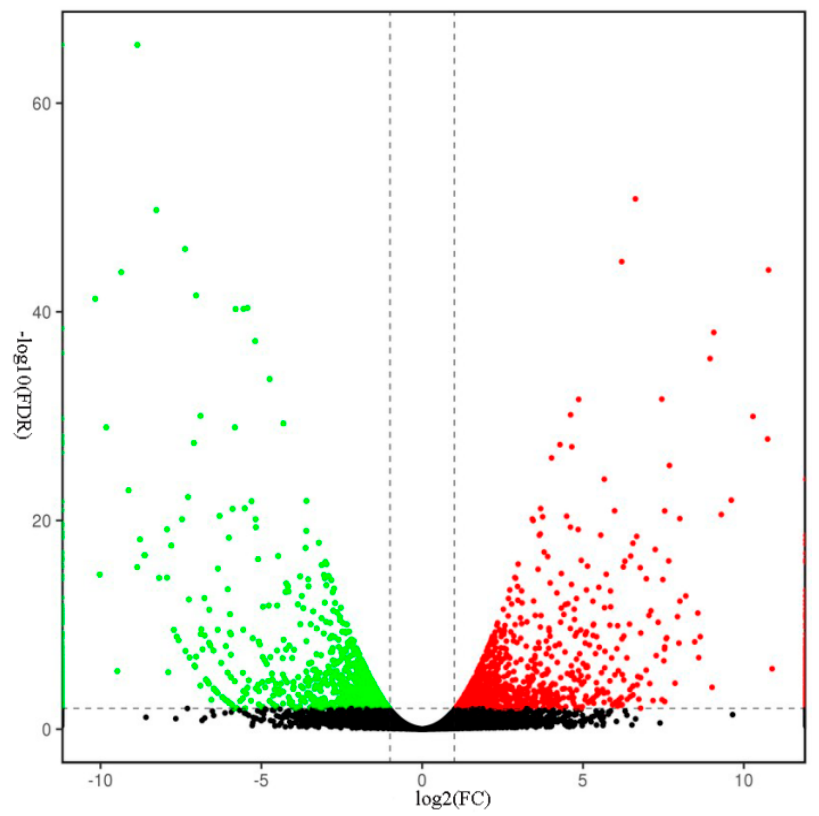
Figure 4. Volcano plot of DEGs between OEJ-10 and the control. Red points represent the DEGs that were upregulated. Black points represent the DEGs without statistically significant differences. Green points represent the DEGs that were downregulated.